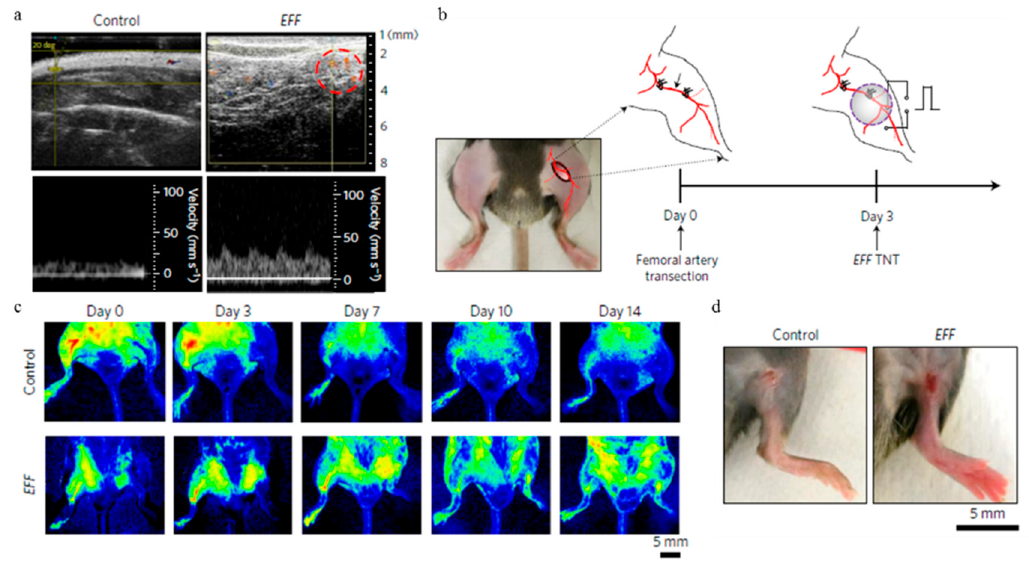
Figure 10. TNT-based enhanced reprogramming factor delivery and propagation can rescue whole limbs from necrotizing ischemia. Reprinted with permission from ref. [81] .